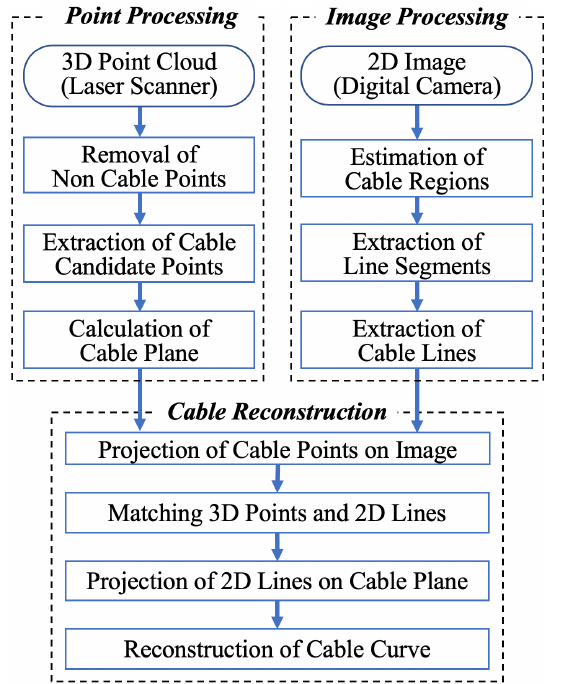
Figure 4. Process of cable